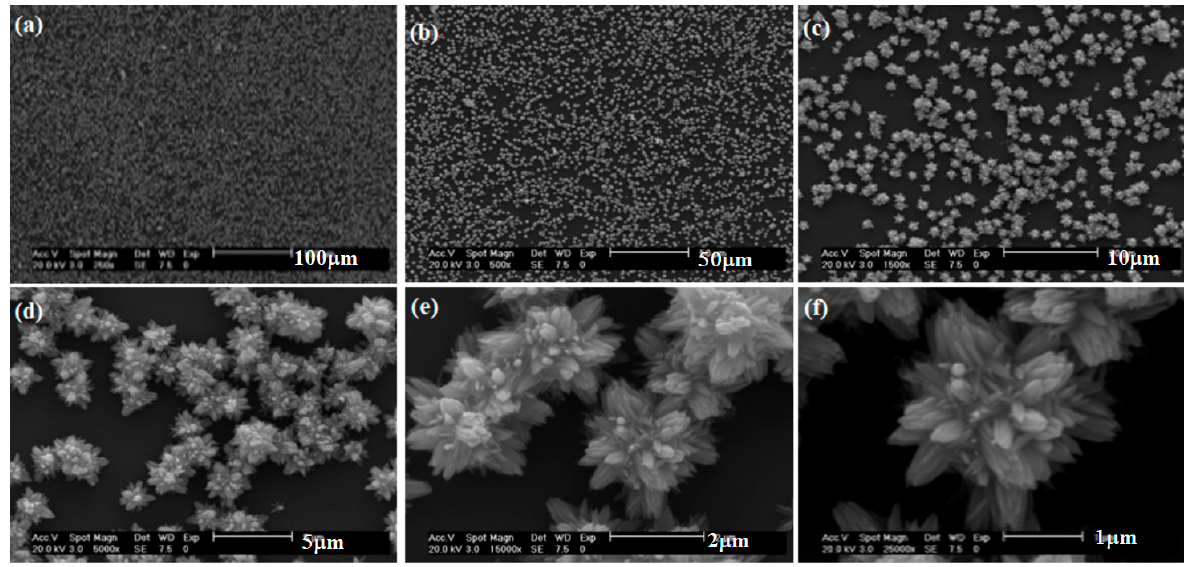
Figure 6. Typical FESEM images of the bunches (nano fl owers) of synthesized ZnO nanosheets at 85 °C for ZnO with pH 11 at di ff erent scales: ( a ) 100 µm, ( b ) 50 µm, ( c ) 10 µm, ( d ) 5 µm, ( e ) 2 µm, ( f ) ◦ C for ZnO with pH 11 at different scales: ( a ) 100 µ m, ( b ) 50 µ m, ( c ) 10 µ m, ( d ) 5 µ m, ( e ) 2 µ m, 1 µm. 85 ( f ) 1 µ